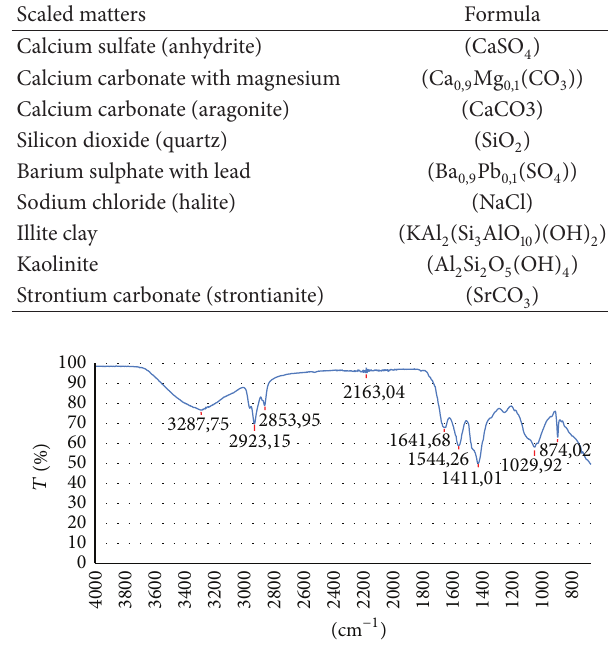
Figure 6: ATR-FTIR spectra of fouled membrane